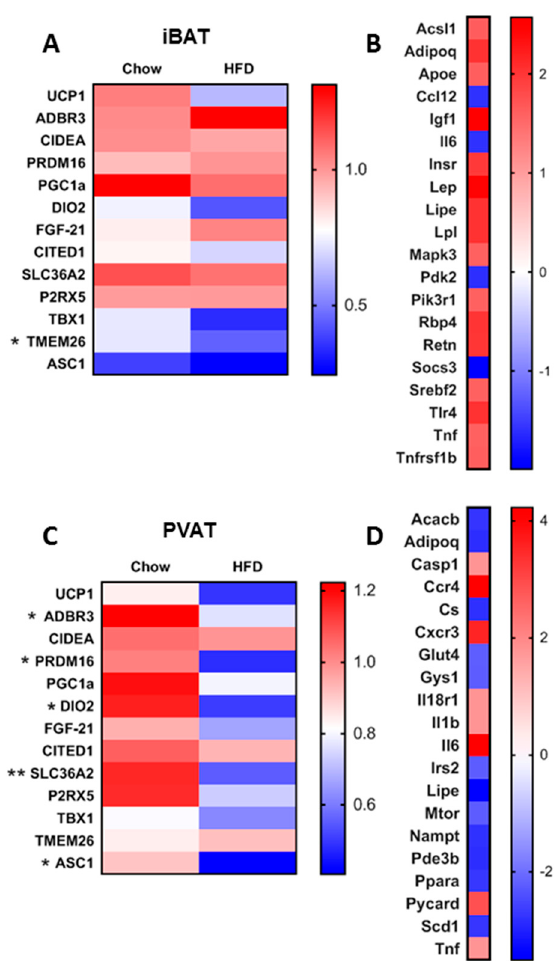
Figure 2. Summary of the effect of the HFD on differences in thermogenic genes involved in brown adipose tissue (BAT), beige and WAT adipocyte function in interscapular BAT (iBAT) (A) and perivascular BAT (PVAT) (C). Top 20 up/down-regulated genes involved in adipose tissue insulin resistance in iBAT (B) and PVAT (D). Data expressed as mean (A and C, n=5-6) or fold change (B and D, n=3). Data were analysed by Students t-test (A and C) with significance denoted as * < 0.05 or ** < 0.01.